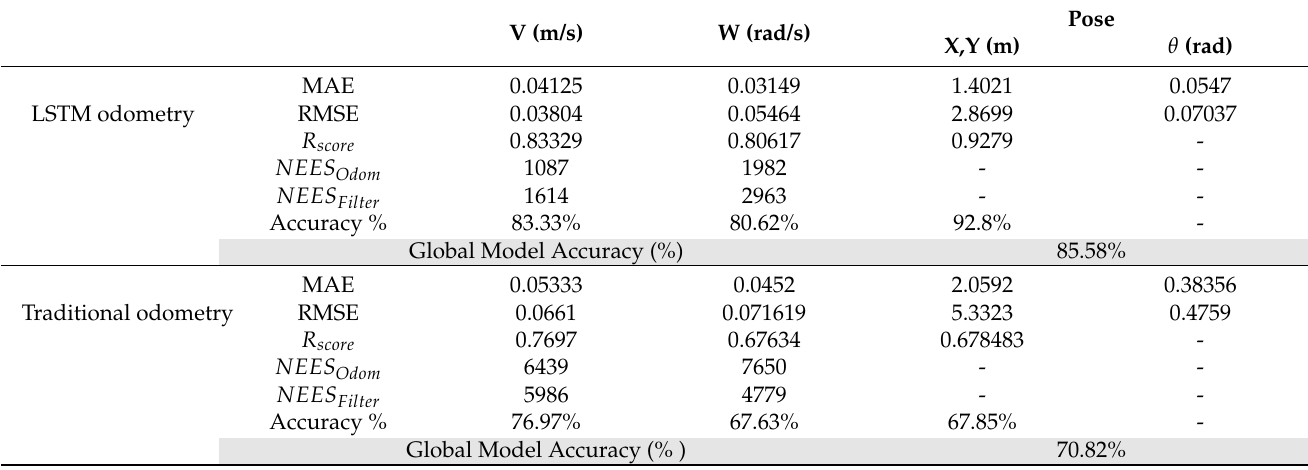
Table 3. Error values obtained by comparing the UKF filter output with respect to the velodyne data in two cases. Using the odometry model with variable covariance and with static